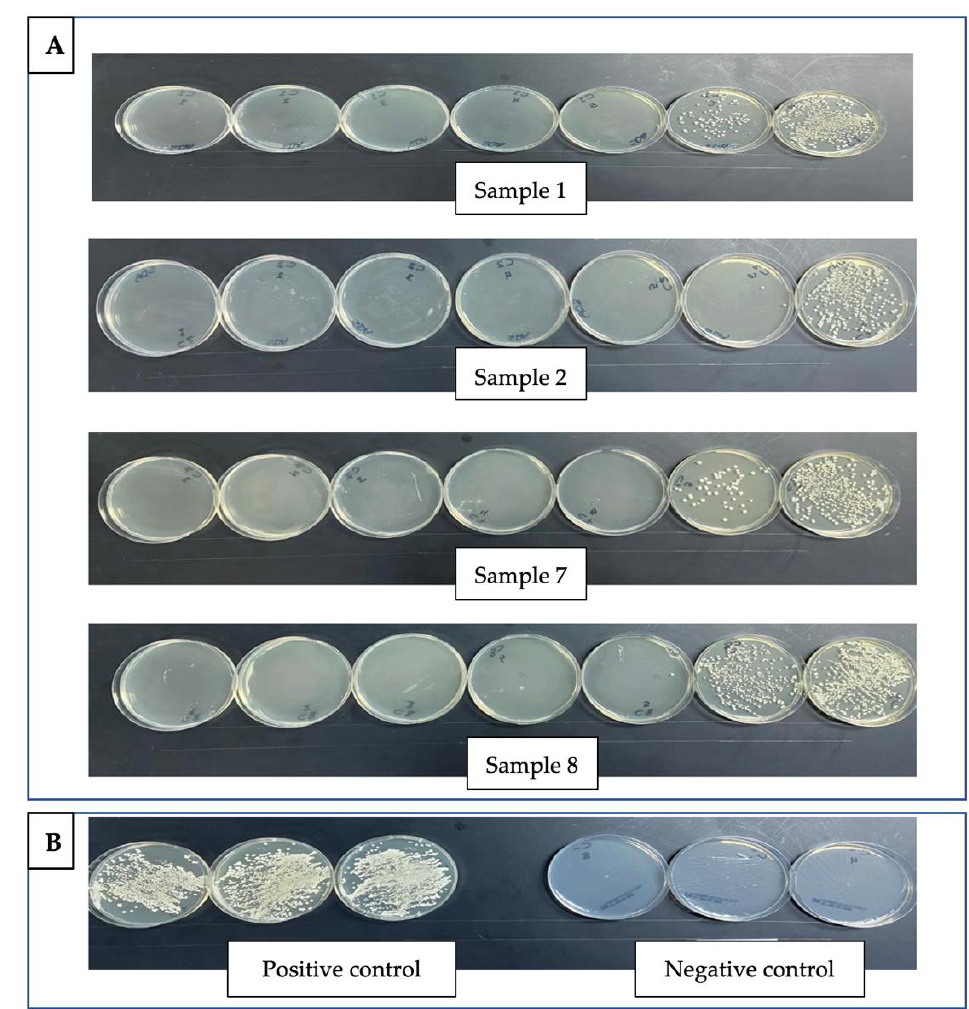
Figure 2. Silver nanoparticles (AgNPs) inhibit the biofilm formation on C. auris clinical isolates. ( A ). Four representative isolates (Sample nos. 1, 2, 7, and 8) and the serial dilution of silver nanoparticles from right to left corresponding from 3.125 to 200 μg/mL. ( B ). Positive and negative control samples. The colony-forming assay shows that AgNPs display effective inhibitory activity against the C. auris isolates.